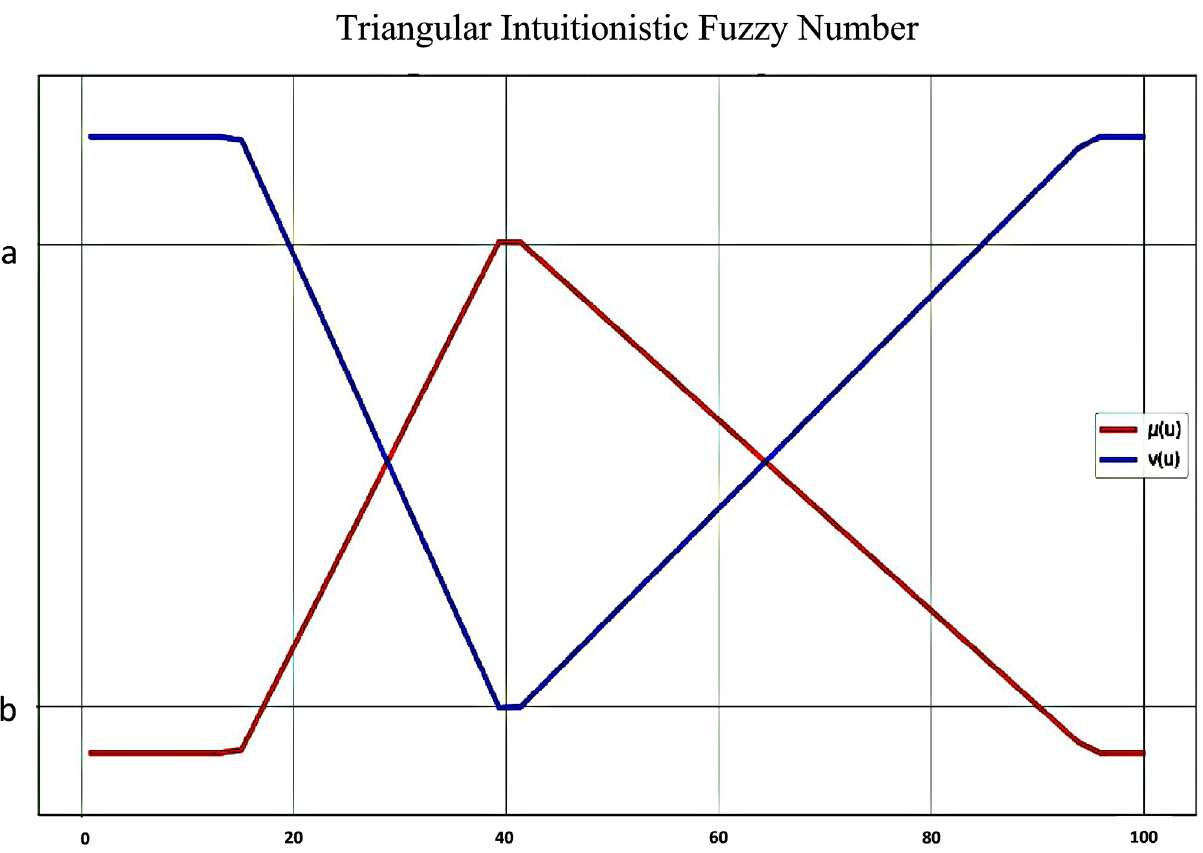
Fig 3. TIFN membership and non-membership